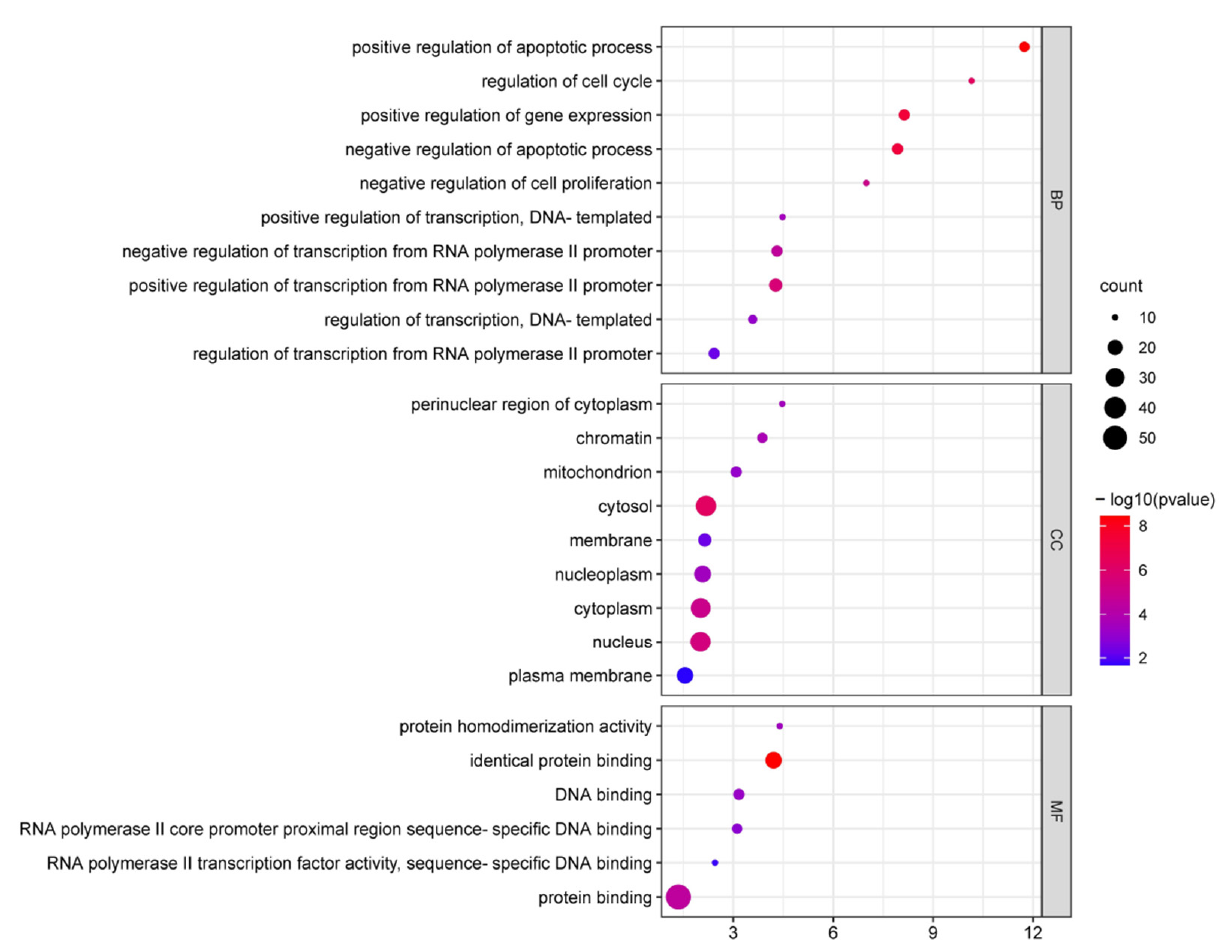
Figure 3. Significant GO terms of ferroptosis-related DEGs.